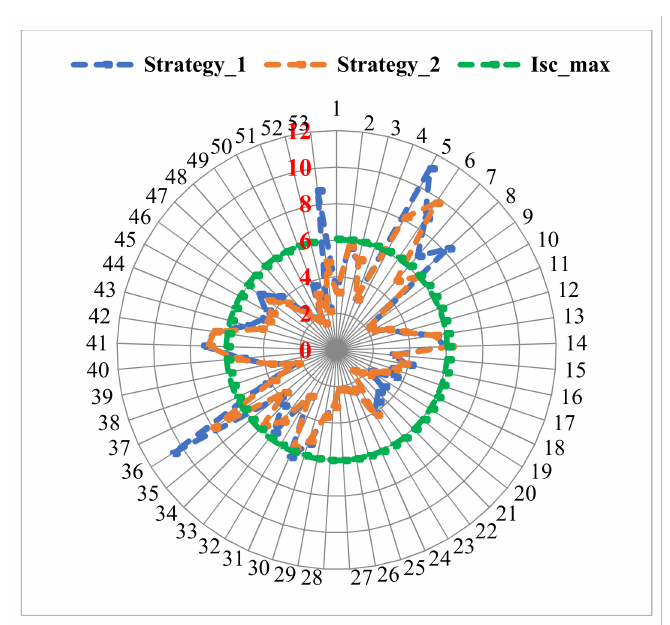
Figure 8. The contour of short-circuit current at each bus without using